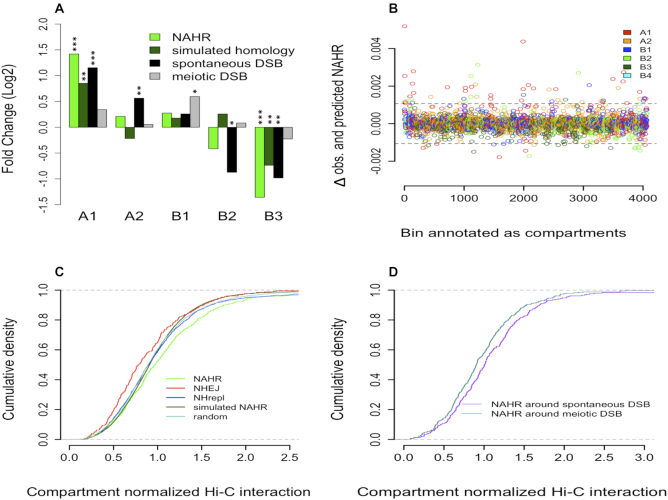
(A) Fold enrichment (Log2 scale) of real NAHR breakpoints, simulated homologous breakpoints, spontaneous and meiotic DSB in five compartments, relative to uniform distribution based on compartment lengths. P values were calculated using chi-square test (* indicates P < 0.05; **P < 0.005; ***P < 0.0005). (B) Differences in the number of observed and predicted NAHR events (using a multiple linear regression model) along each compartment segment. Values closer to zero imply better prediction. Dotted lines represent 3 standard deviations from the mean. Bins with values outside the dotted lines represent discordant predictions. (C) Cumulative density of Hi-C interaction observed between breakpoints of SVs in different classes, advance simulated NAHR breakpoints, and random points. Original interaction values were normalized based on a background distribution for each compartment. This eliminated the effect of overall stronger interactions in B compartments, facilitating an unbiased comparison (Supplementary Figure S7). (D) Cumulative density of normalized Hi-C interaction for NAHR breakpoints with only spontaneous DSB or only meiotic DSB within 1 kb.